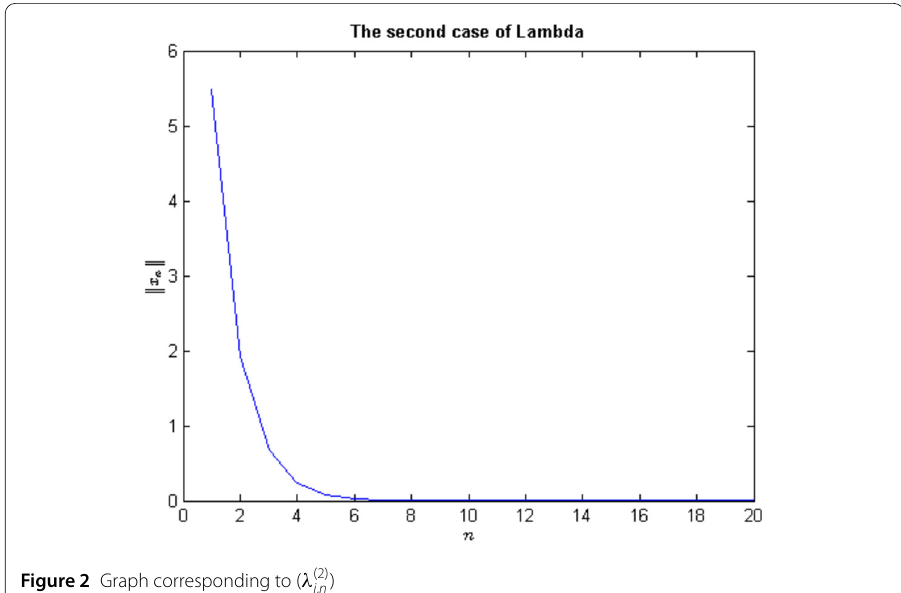
Figure 2 Graph corresponding to ( λ (2) i , n )